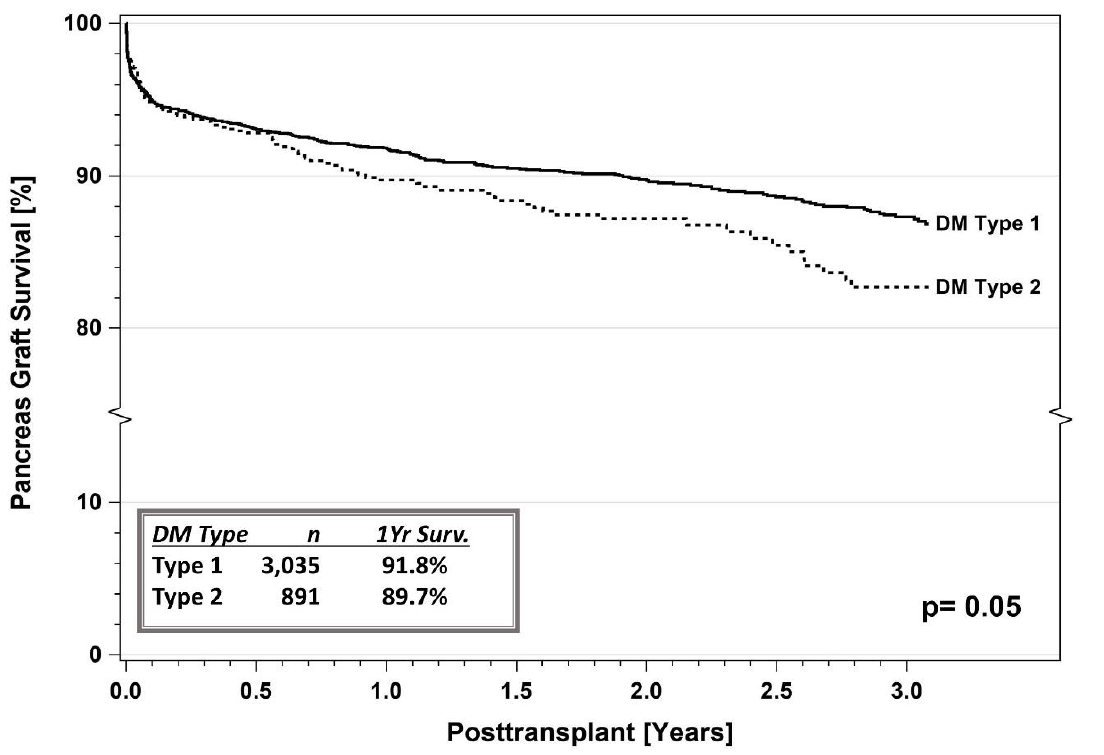
Figure 6. SPKT pancreas graft survival according to diabetes type in the latest era (1 January 2017 – 31 December 2021) for US cases as reported to the IPTR. Surv. = Survival.